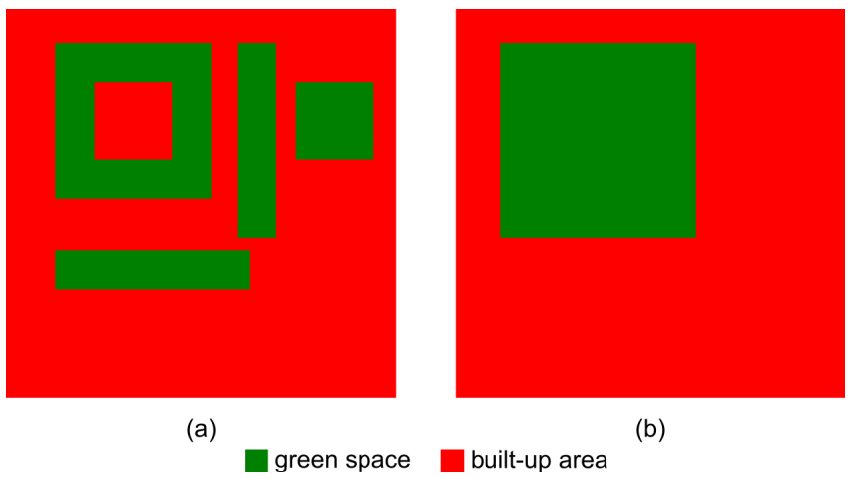
Figure 1. Schematic illustration of the loss of information due to lumping green areas. ( a ) Real landscape pattern; ( b ) the lumped area used in many previous ecosystem services (ES) studies.